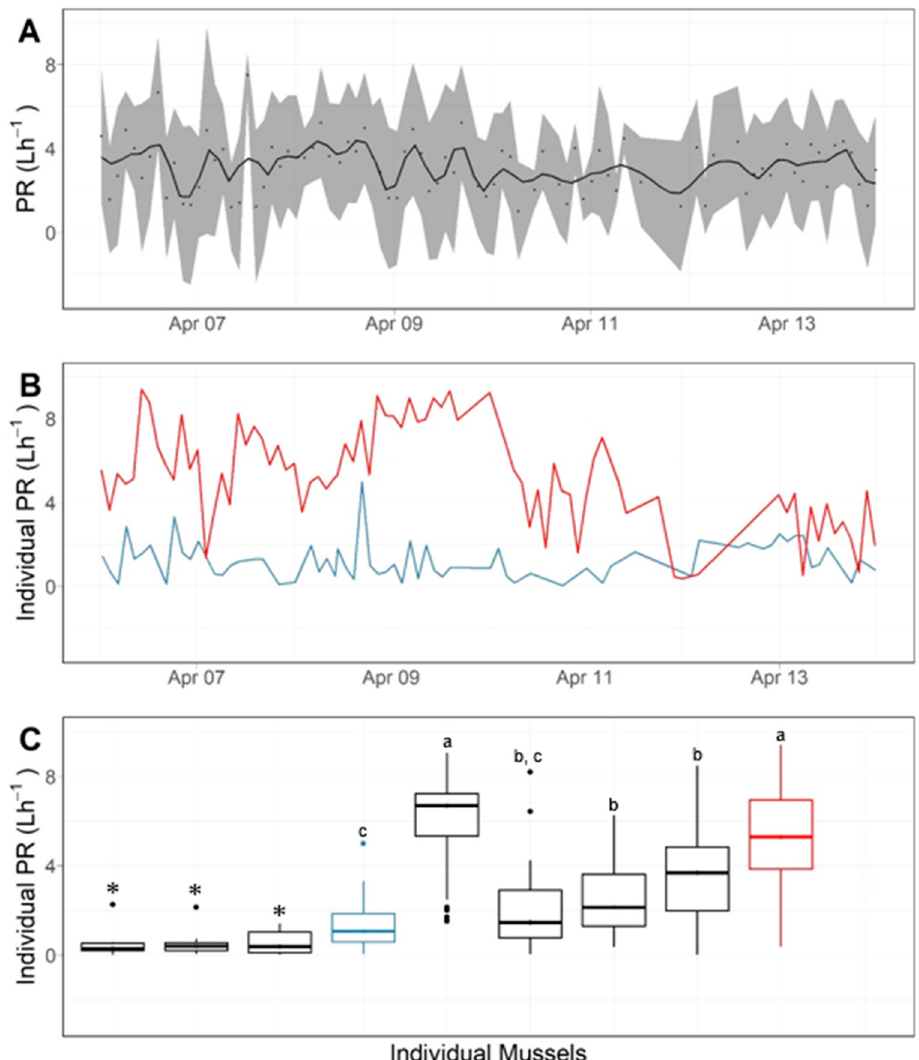
Figure 3. Summary of pumping rate (PR) (Lh − 1 ) data from Exp. 3: ( A ) median PR of all individuals ± SD over 4 days. ( B ) Individual PR of two mussels with low (blue) and high (red) interquartile range in PR. ( C ) Boxplots of the summarized PR of all individuals over the entire experiment; letters a–c above boxplots indicate statistically significant differences at p < 0.0001. * Indicates individual mussel not included in median